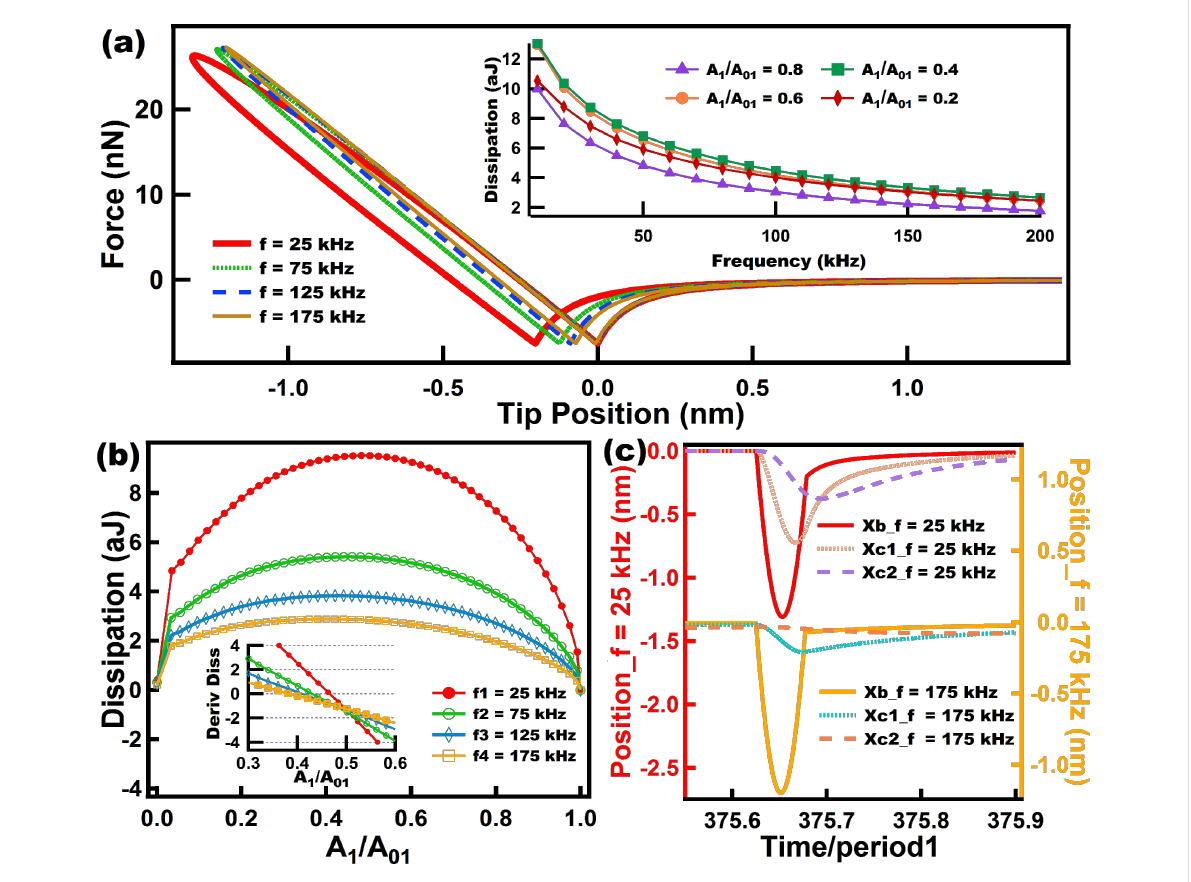
Figure 7: Results of energy dissipation when a numerically simulated tip trajectory in intermittent contact AFM interacts with a Nafion model. (a) shows force–distance curves for tips driven at different eigenfrequencies (color coded). The inset in (a) shows the behavior of the dissipation as the frequency grows, and each color-coded line relates to a specific amplitude setpoint ( A 1 / A 01 ). (b) shows dissipation vs amplitude setpoint ( A 1 / A 01 ) curves in which each color-coded line corresponds to a specific eigenfrequency. The inset in (b) shows the slope of the curves in (b) near the range where the slopes cross the x -axis in order to easily locate the maxima of the curves in (b). (c) shows the response of the surface and dashpots of the Nafion model for two cases at different cantilever eigenfrequencies. The parameters for the cantilever dynamics are the same as in Figure 6. The sample parameters use were: k e = 20 N/m, k 1 = 10 N/m, k 2 = 5 N/m, and c 1 = c 2 = 1.0 × 10 − 5 N·s/m. Time normalization has been carried out in (c) with respect to the fundamental period for ease of